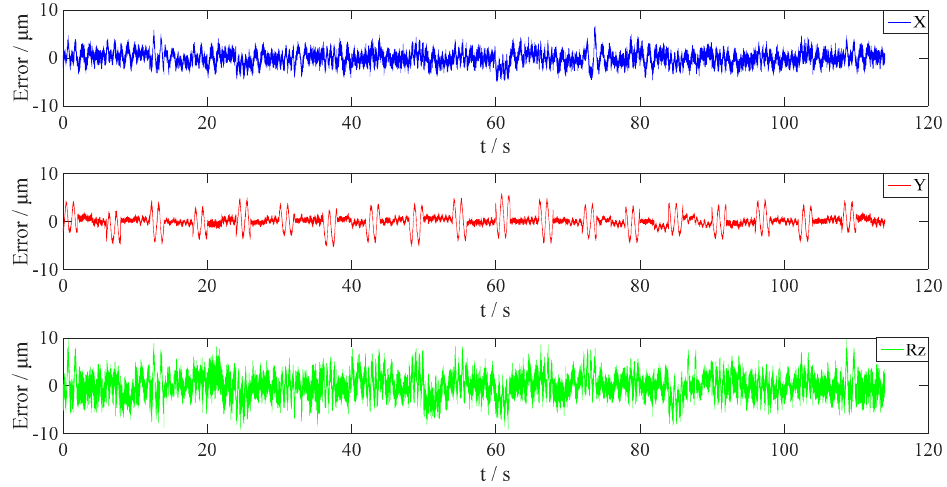
Figure 12. The output errors in horizontal 3-DOFs with the optimized parameters using Model (31). Table 8. The statistics of the horizontal 3-DOFs’ outputs with optimized parameters using Model (31).